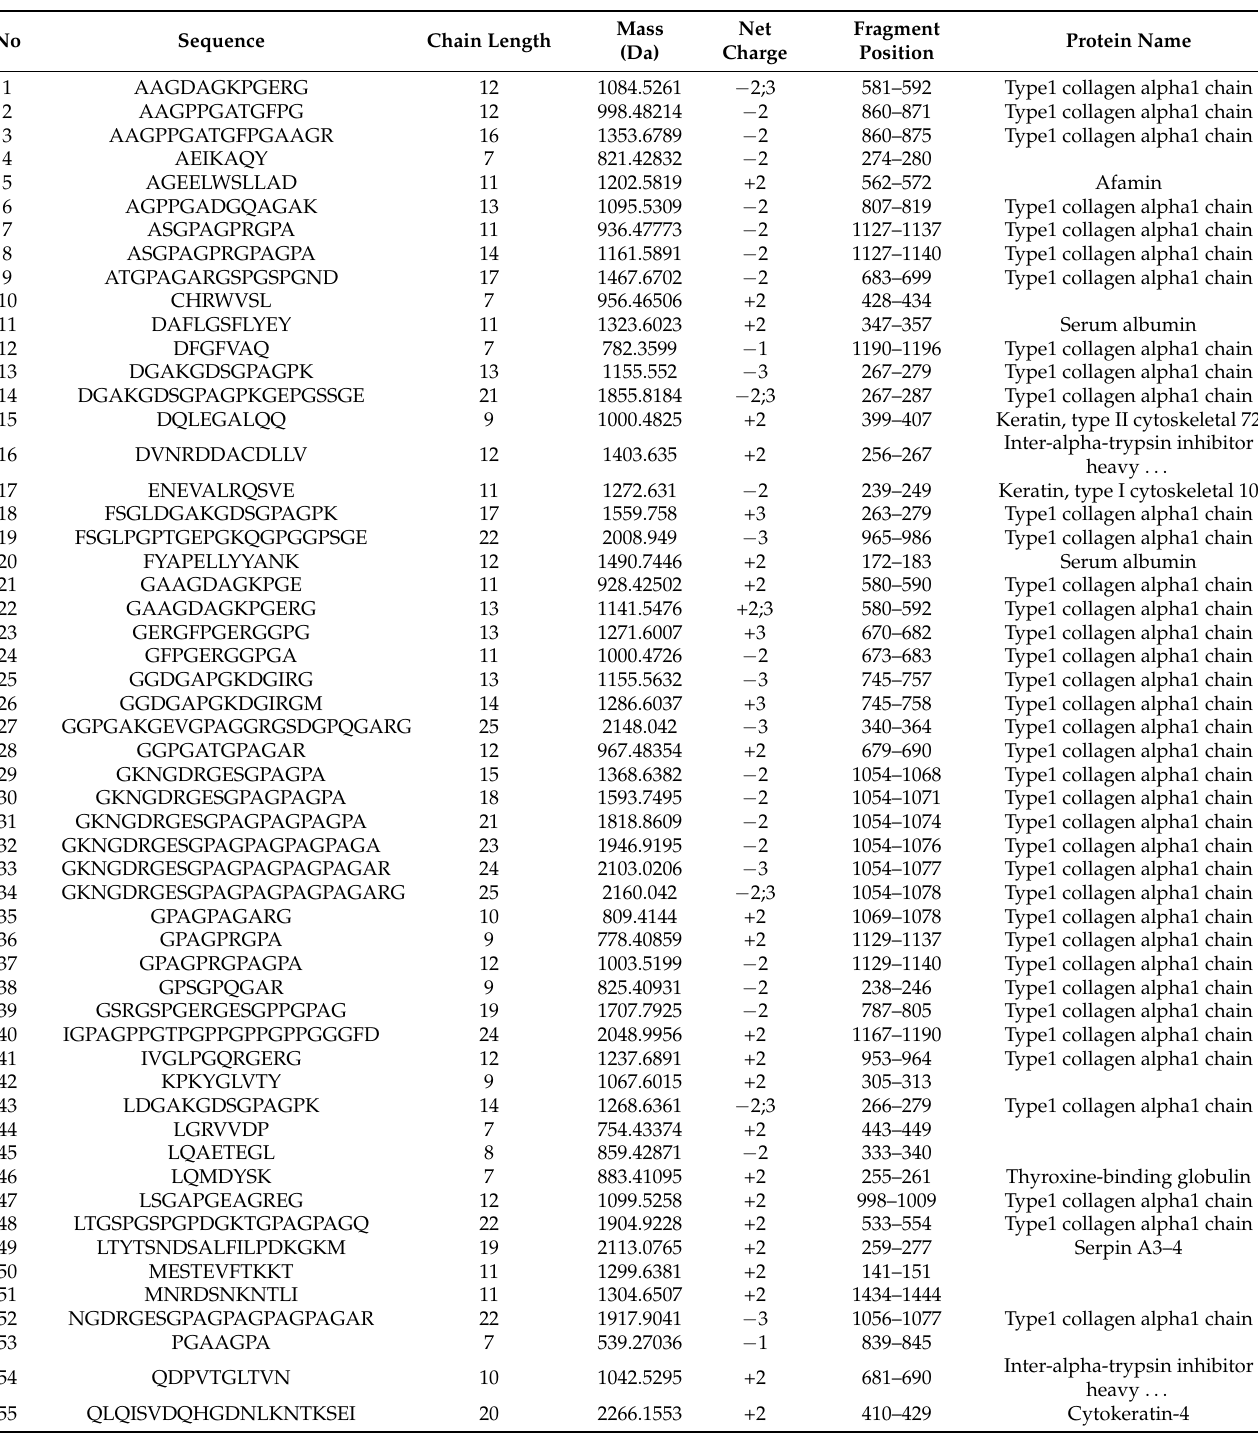
potent antibacterial activities against the Gram-negative bacteria. The length of identified peptides ranged from 6 to 22 and 6 to 24 amino acid residues, and the molecular mass ranged from 612.3 to 2266 Da and 540.2 to 2586 Da for the Neutrase and papain fractions, respectively. The vast majority of peptides in both samples were derived from Type 1 collagen alpha 1 chain, the main collagen protein component. In general, lower molecular weight peptides with 2–5 amino acid residues are less accurately identified by the shotgun peptidomics approach and, if present in the fractions, were not detected in this study. Table 3. Collagen peptides identified in the acetone fraction of the hydrolysate produced with